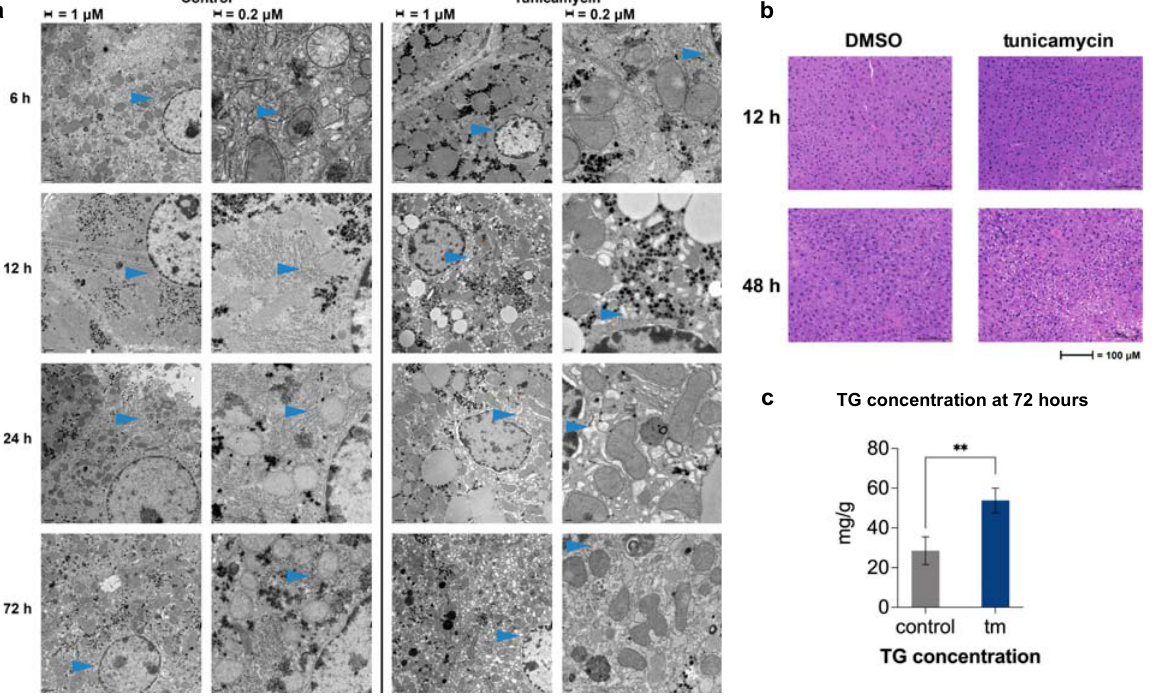
Figure 3. ( a ) Electron microscopy (TEM) images of liver sections 12–72 h post DMSO (control) or with 1.5 mg/kg tunicamycin treatment. Arrows point out ER in both treated and control to highlight changes in morphology. ( b ) H&E staining of liver sections 12 and 48 h post DMSO or with 1.5 mg/kg tunicamycin treatment. ( c ) Concentration of triglycerides in mouse liver lysate post DMSO (control) or with 1.5 mg/kg tunicamycin treatment. (Tm = tunicamycin ‐ treated). ** = <0.01